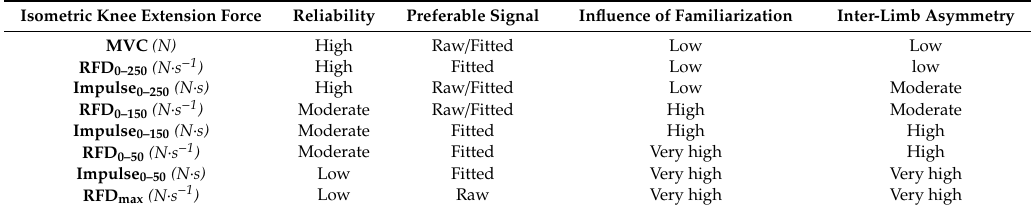
Table 4. Recommendations on maximal isometric knee extension force assessment based on reliability (intra-session level of agreement), preferable signal (raw: original; fitted: filtered) and the influence of a familiarization session (test-retest di ff